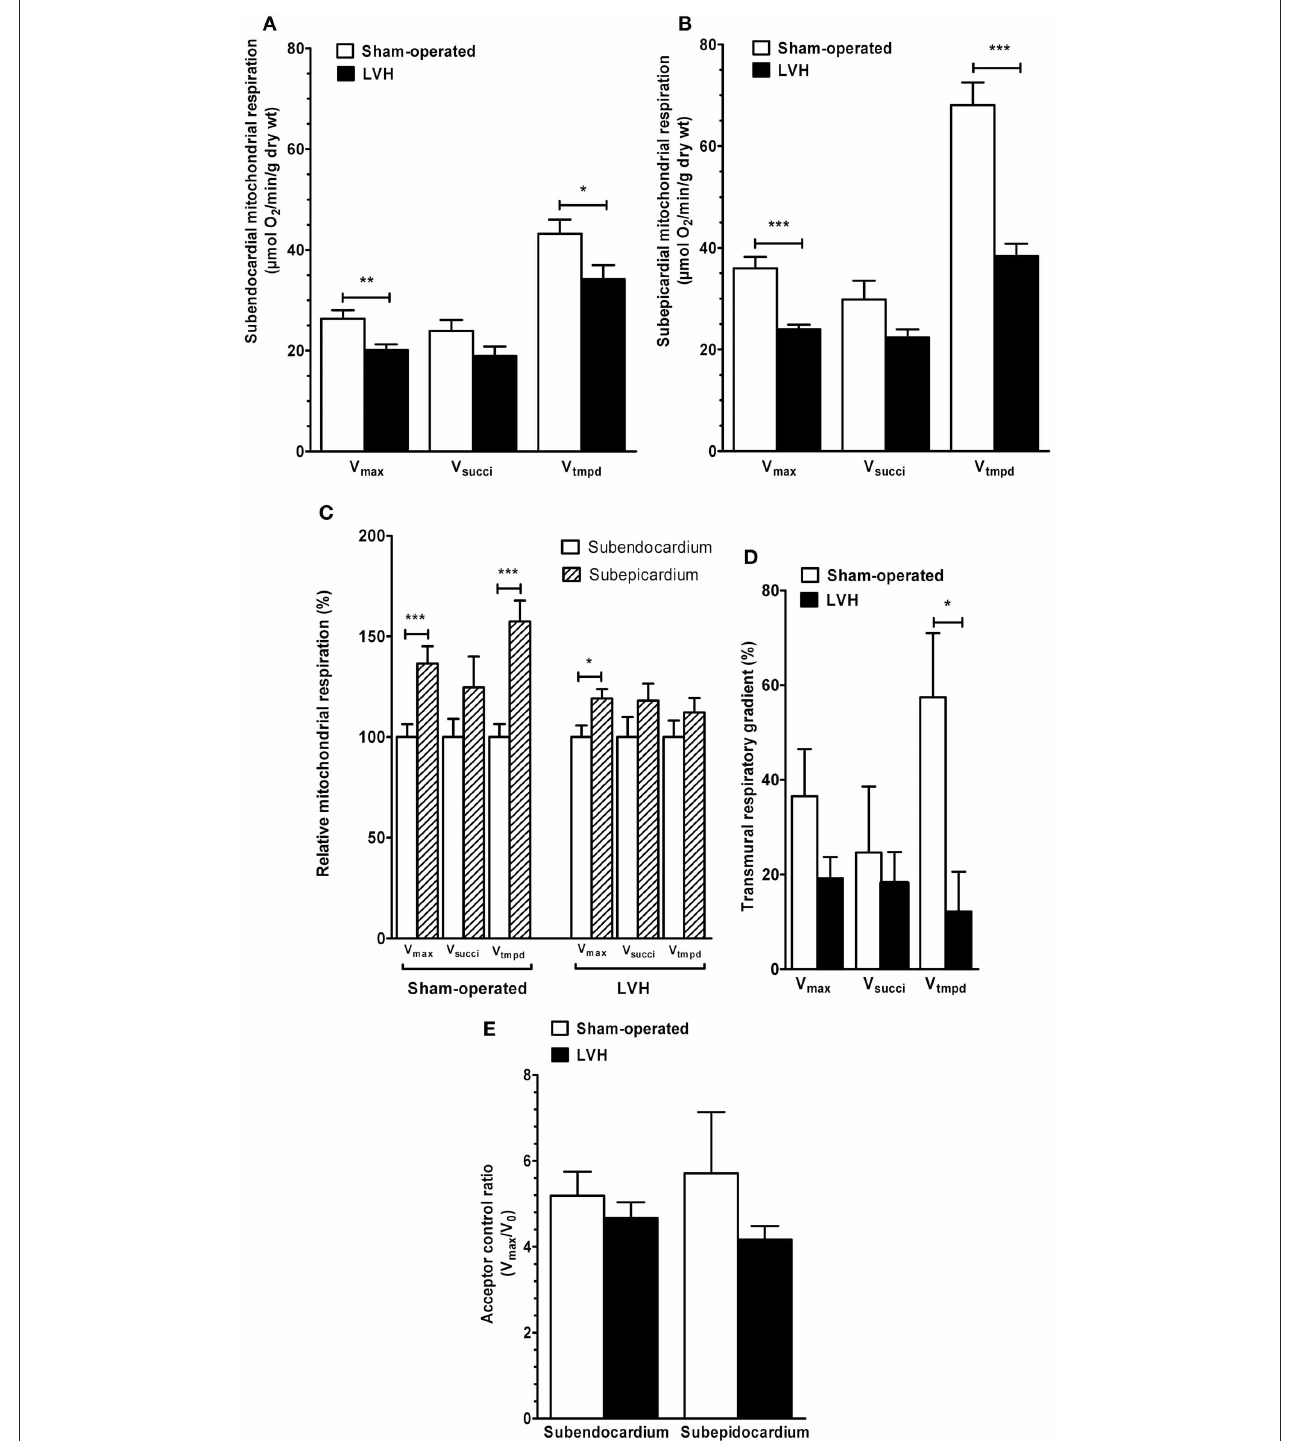
FIGURE 1 | Subendocardium and subepicardium LV mitochondrial respiratory chain complex activities and acceptor control ratio in sham-operated and LVH groups. (A) Subendocardium mitochondrial respiratory chain complex activities. (B) Subepicardium mitochondrial respiratory chain complex activities. (C) Relative mitochondrial respiration in subendocardium and subepicardium, with the subendocardium layer considered as the reference (100%). (D) Transmural differences in